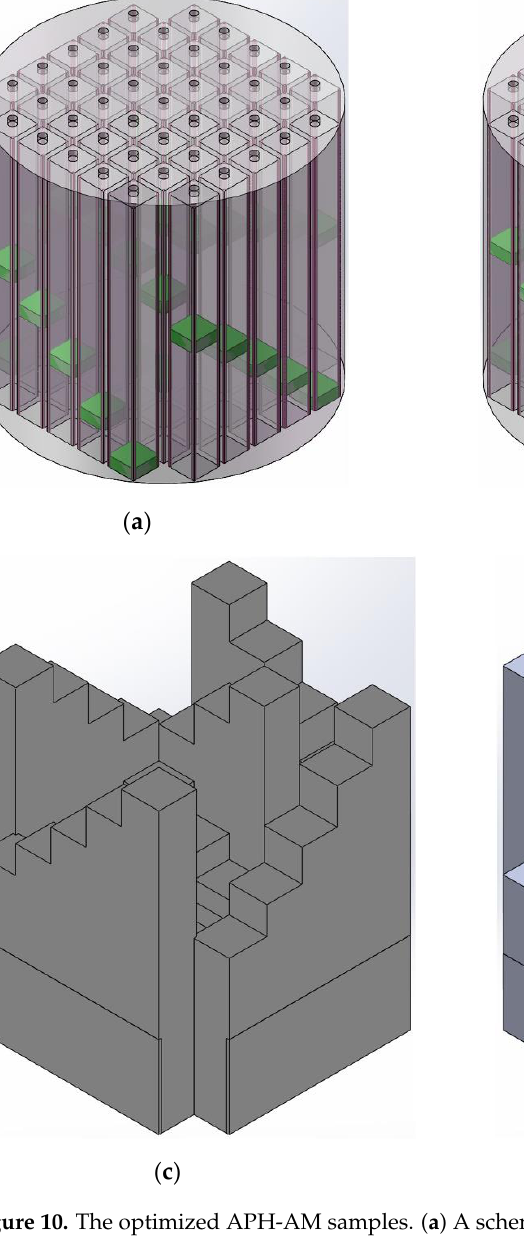
Figure 10. The optimized APH-AM samples. ( a ) A schematic diagram of sample for the target with all the sound absorption coefficients above 0.9; ( b ) a schematic diagram of sample for the target with all the sound absorption coefficients above 0.85. ( c ) the equivalent structure of the sample for the target with all the sound absorption coefficients above 0.9; ( d ) the equivalent structure of the sample for the target with all the sound absorption coefficients above 0.85.